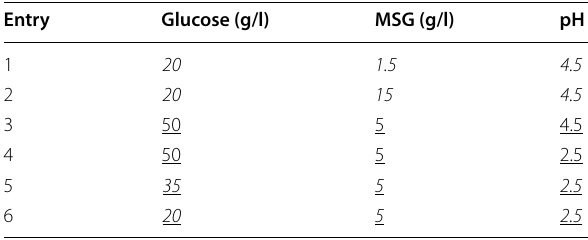
Table 1 Collection of mycelia from various cultivation con-